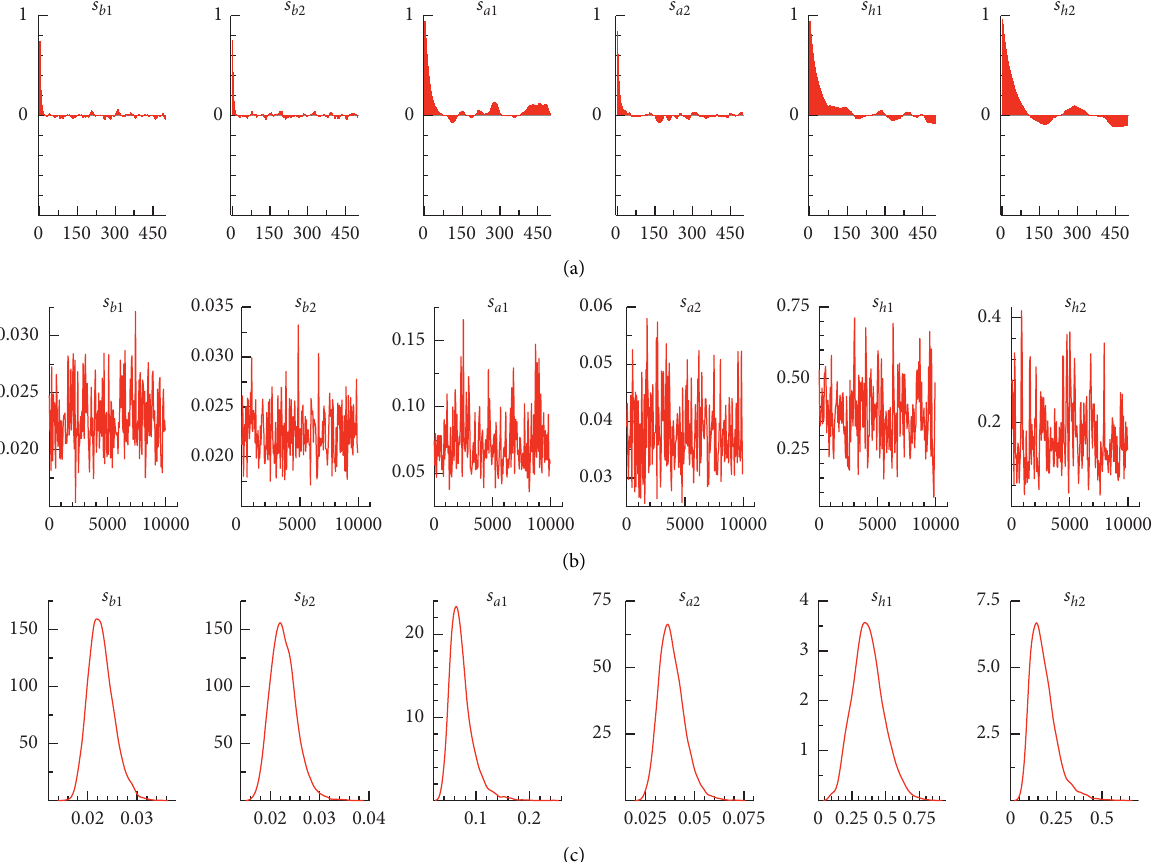
Figure 3: Estimation results of selected parameters in the TVP-VAR model. Sample autocorrelations (a), sample paths (b), and posterior densities